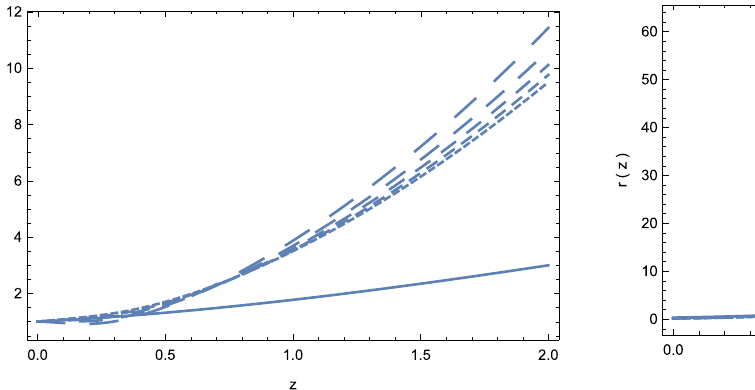
Fig. 11 Variation as a function of the redshift of the matter energy density r ( z ) for the geometry-matter coupling function F η e μ ˜ Q / 6 + ν ˜ T for M = 1 . 7, η = 6 /μ , ν = 20, and for different values of μ : μ = 1 . 7 (dotted curve), μ == 1 . 5 (short dashed curve), μ = 1 . 3 (dashed curve), μ = 1 . 1 (long dashed curve), and μ = 0 . 9 (ultra- long dashed curve). To integrate the system of cosmological evolution equations we have used the initial conditions h ( 0 ) = 1, (cid:18)( 0 ) = 0 . 058, and (cid:4)( 0 ) = 0 . 0235. The solid curve represents the evolution of the matter density in the standard (cid:4) CDM cosmological